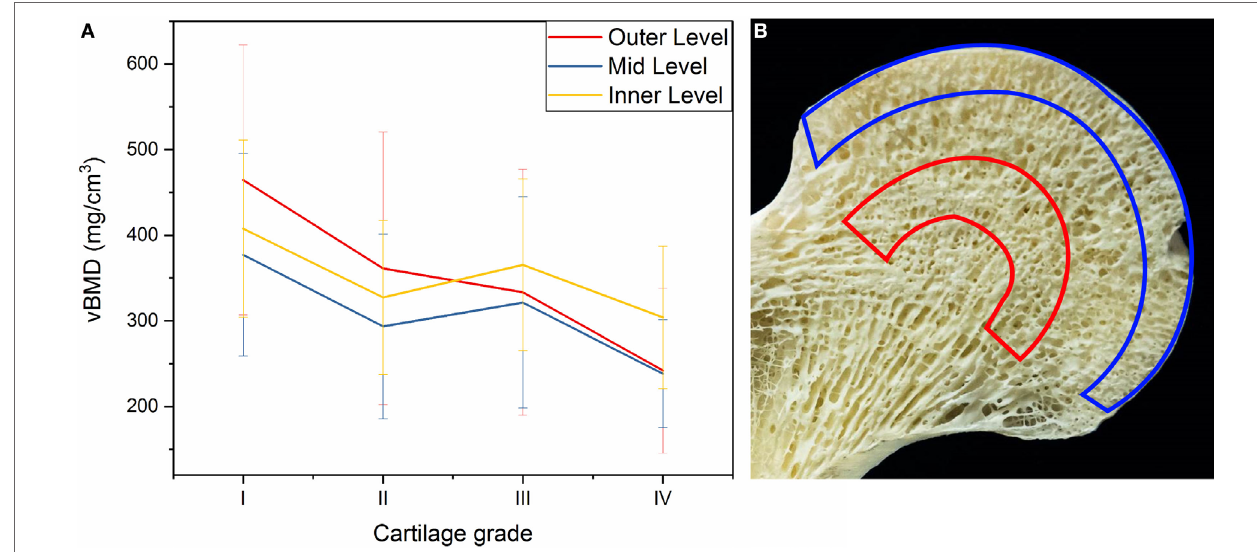
FigUre 6 | (a) Changes in volumetric bone mineral density (vBMD) of OA femoral heads in outer, mid, and inner levels according to cartilage grading. (B) Outer and inner levels are highlighted (blue and red, respectively) in the femoral head to illustrate the density of each